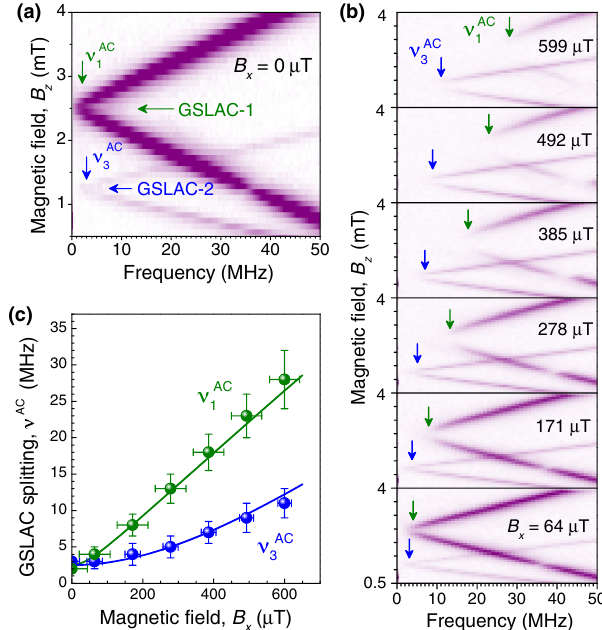
FIG. 3. (a) Evolution of the ν 1 and ν 3 ODMR lines in the vicinity of GSLACs as a function of the magnetic field B perpendicular components of the geomagnetic field are compen- sated. (b) Same as (a), but measured for nonzero B arrows indicate the positions of the turning points ν AC 1 and ν AC 3 , which are a direct measure of the level splittings at GSLAC-1 and GSLAC-2, respectively. (c) The GSLAC splittings as a function of B . The solid lines are calculations as explained in the x